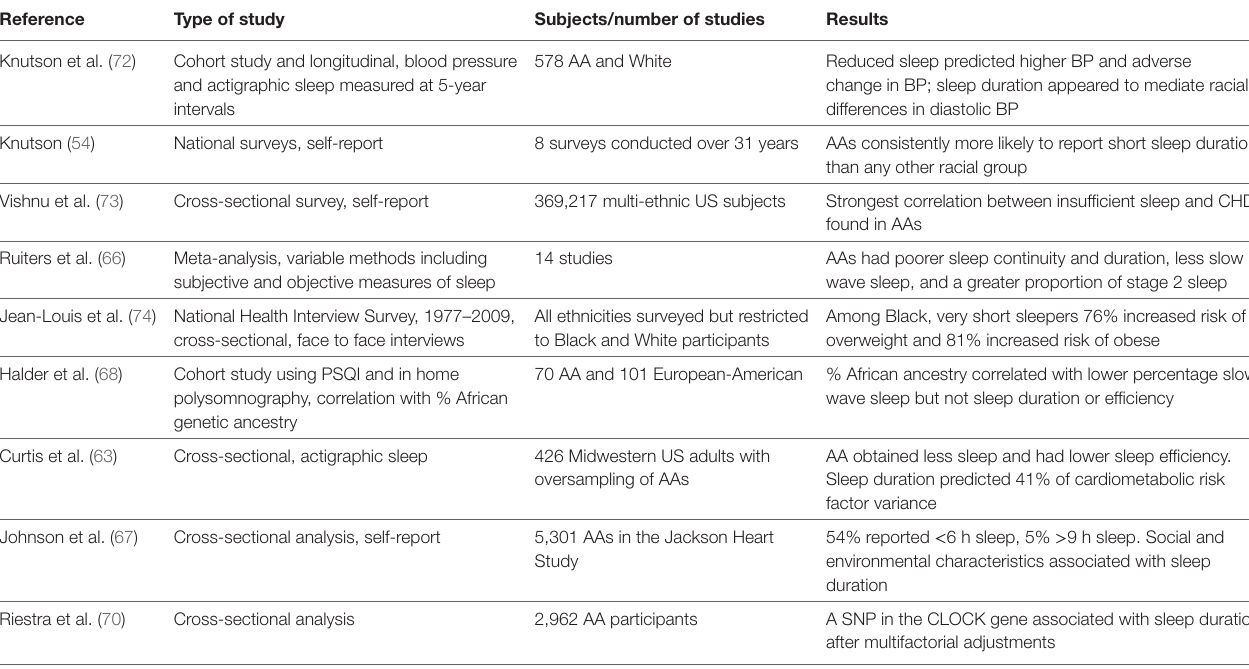
TAbLe 1 | Summary of studies examining sleep duration and cardiometabolic diseases in African-Americans